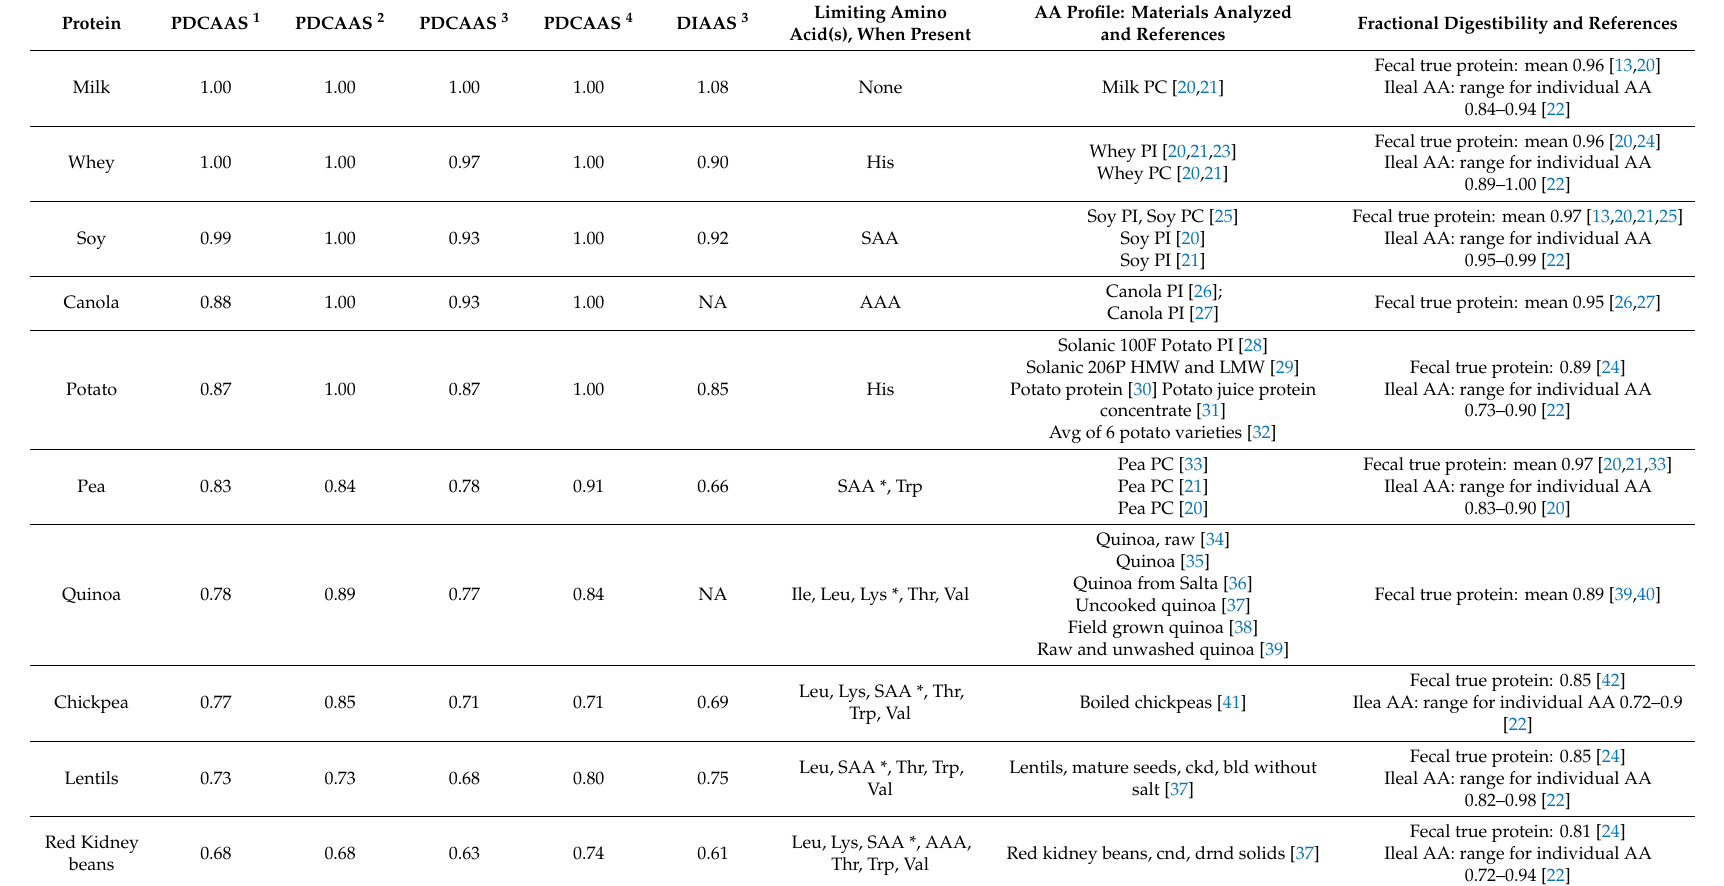
Table 2. Protein quality of whey and selected vegetable protein